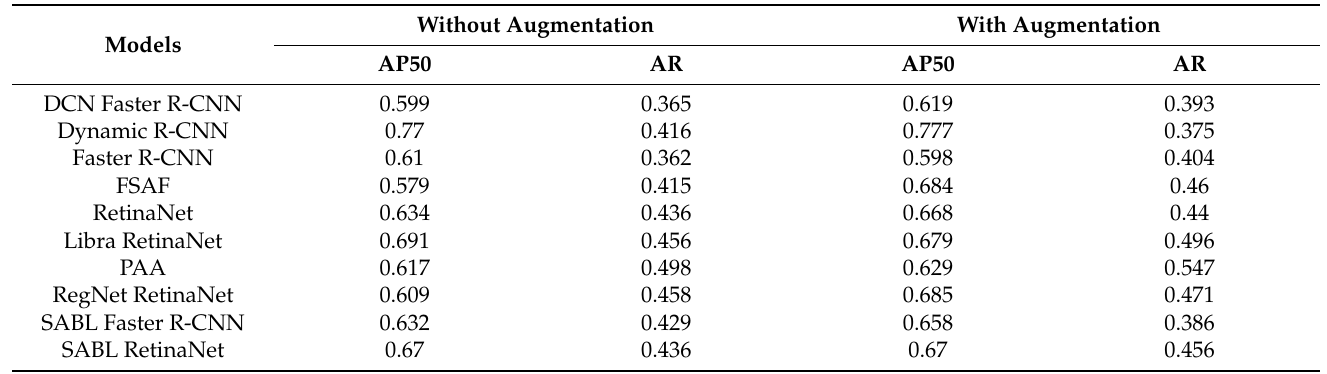
Table 6. Validation AP50 and AR results of detection models.